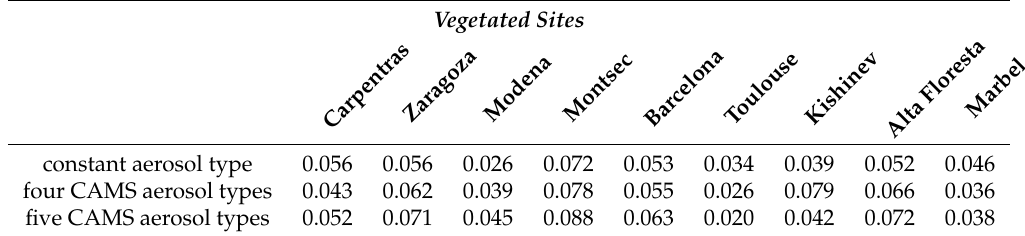
Table 5. Root-mean-square error (RMSE) of aerosol optical thickness (AOT) at 550 nm estimated by the MACCS-ATCOR Joint Algorithm (MAJA), over each vegetated site. CAMS: Copernicus Atmosphere Monitoring